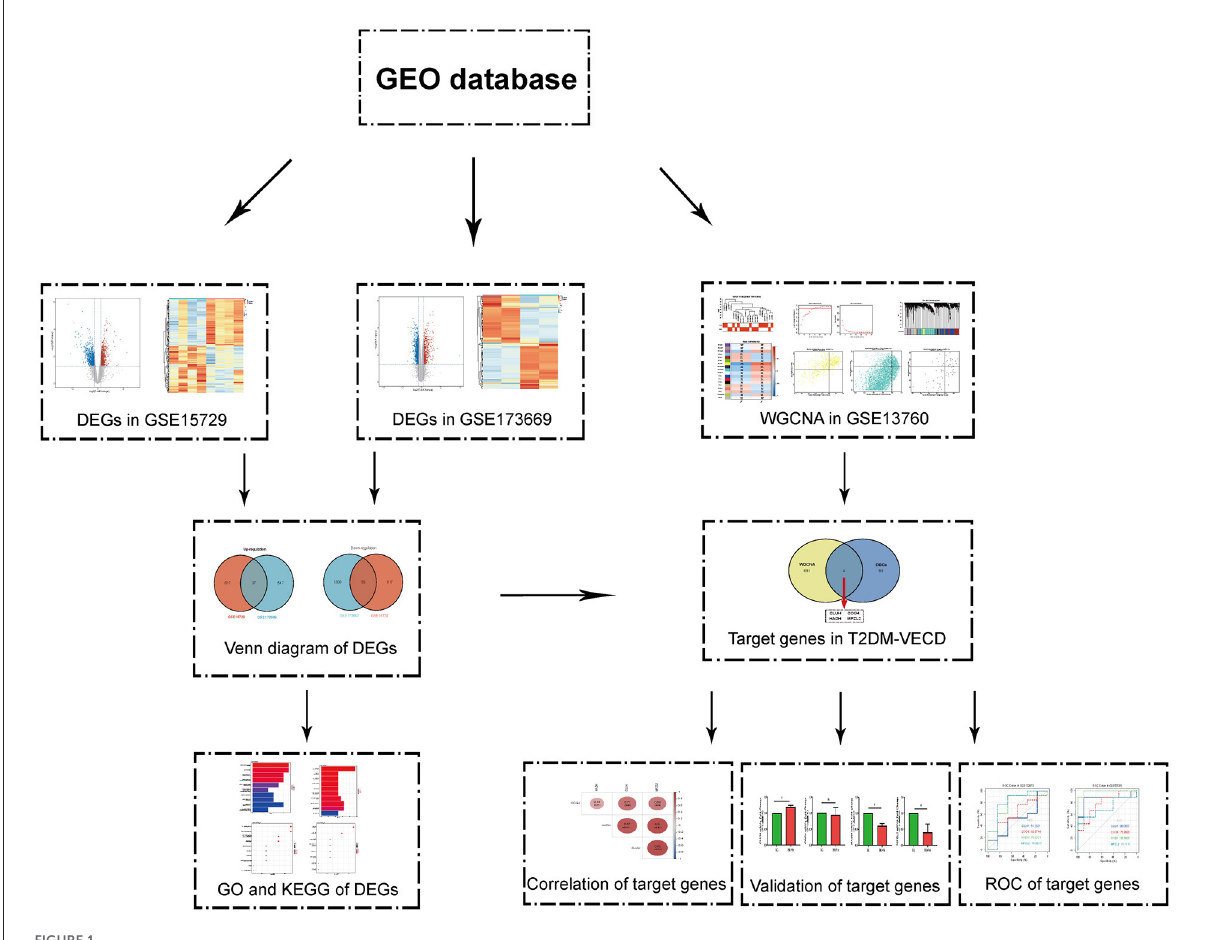
FIGURE1 The flowchart of the